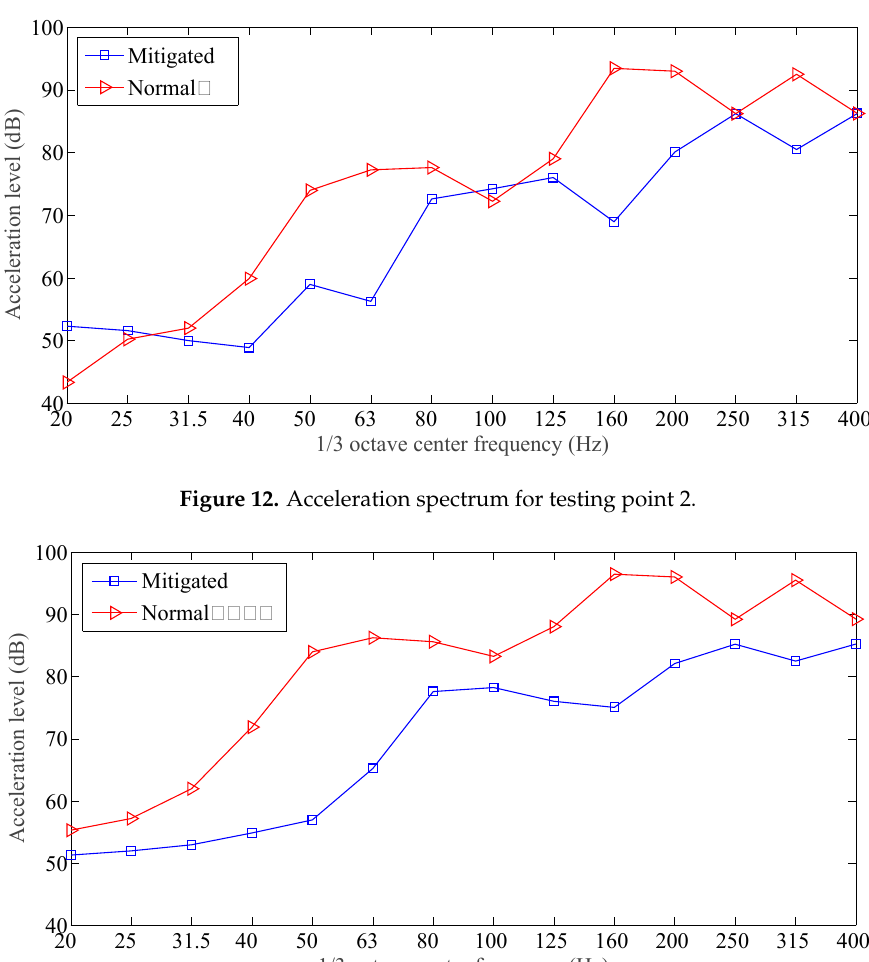
Figure 11. Acceleration spectrum for testing point 1.